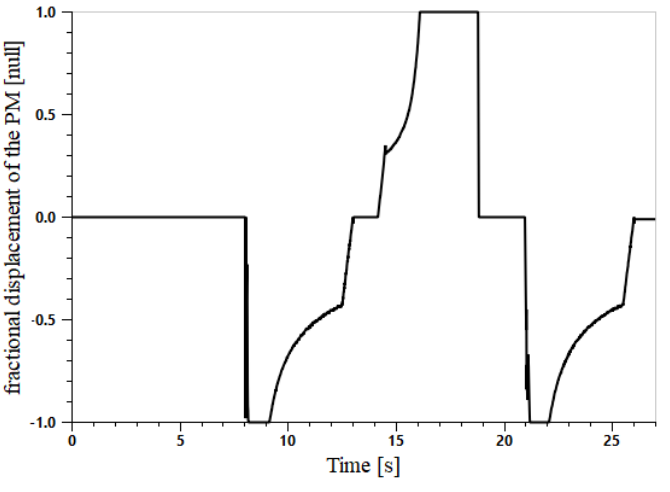
Figure 24. The PM displacement of the proposed system when the excavator bucket is full.